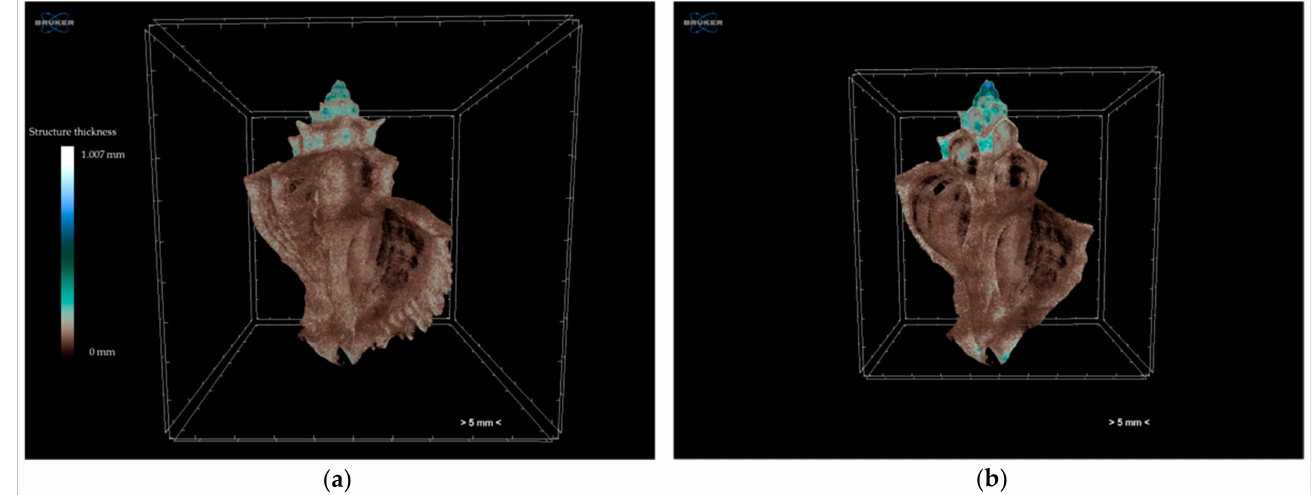
Figure 4. Colour-coded structure thickness images of ( a ) whole specimen and ( b ) cross-section along the specimen of an adult Hexaplex trunculus shell acquired using a Skyscan 1172 micro-CT scanner.